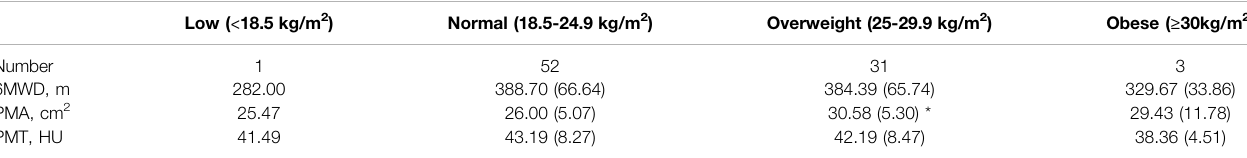
TABLE 6 | The regression analyses between the PMA and PMT measurements and 6MWD in patients with stable COPD adjusting for age, sex, BMI classi fi cation, smoking pack-years, FEV1%pred, current smoking status, emphysema percentage, and TAC of RB1. Predictor Mean Difference per cm 2 95% CI P -value Mean Difference per HU Increment in Increment in pectoralis muscle attenuation pectoralis muscle cross-sectional area